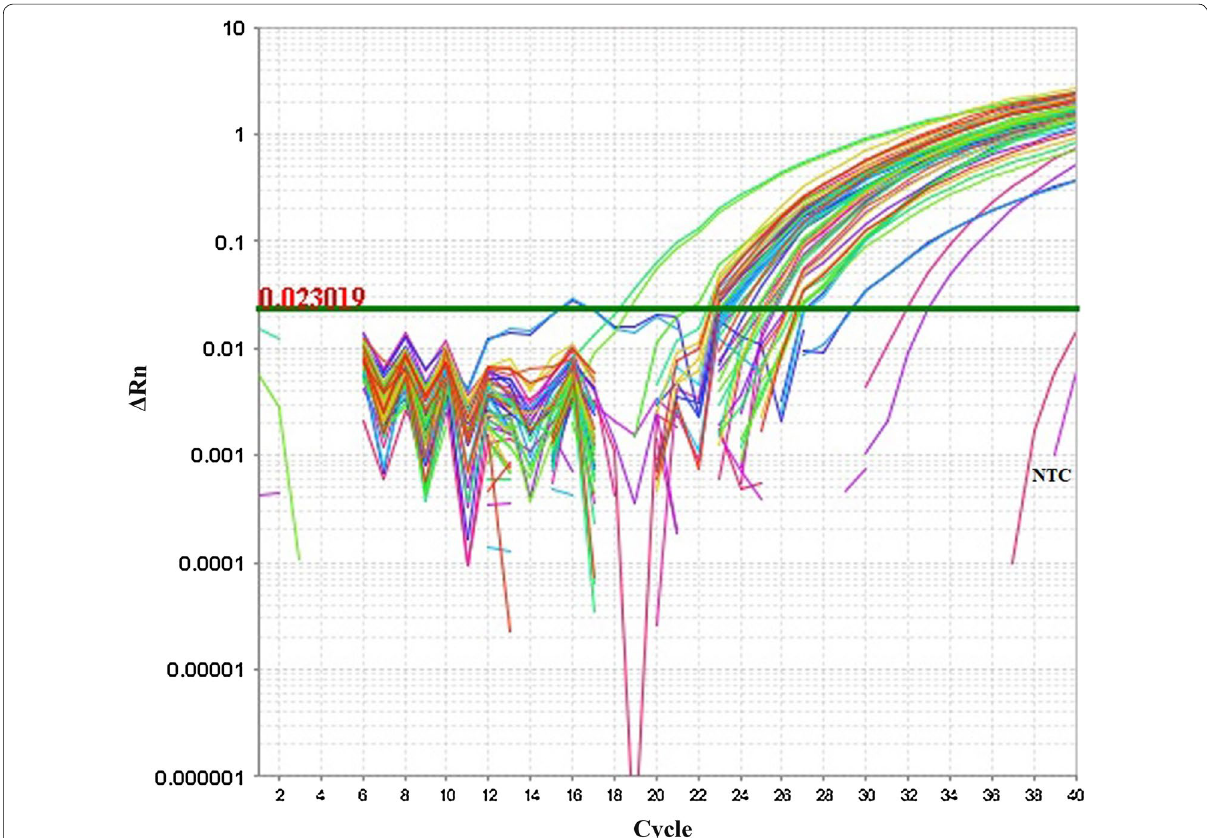
Fig. 1 Amplification plots of WSSV positive samples and no template control (NTC). The amplification of positive samples was confirmed by signifi‑ cant fluorescent signal overhead the base line. The significant fluorescent signal above the baseline was not spotted for the negative control (NTC). The C T (cycle threshold) value of NTC was beyond the determination